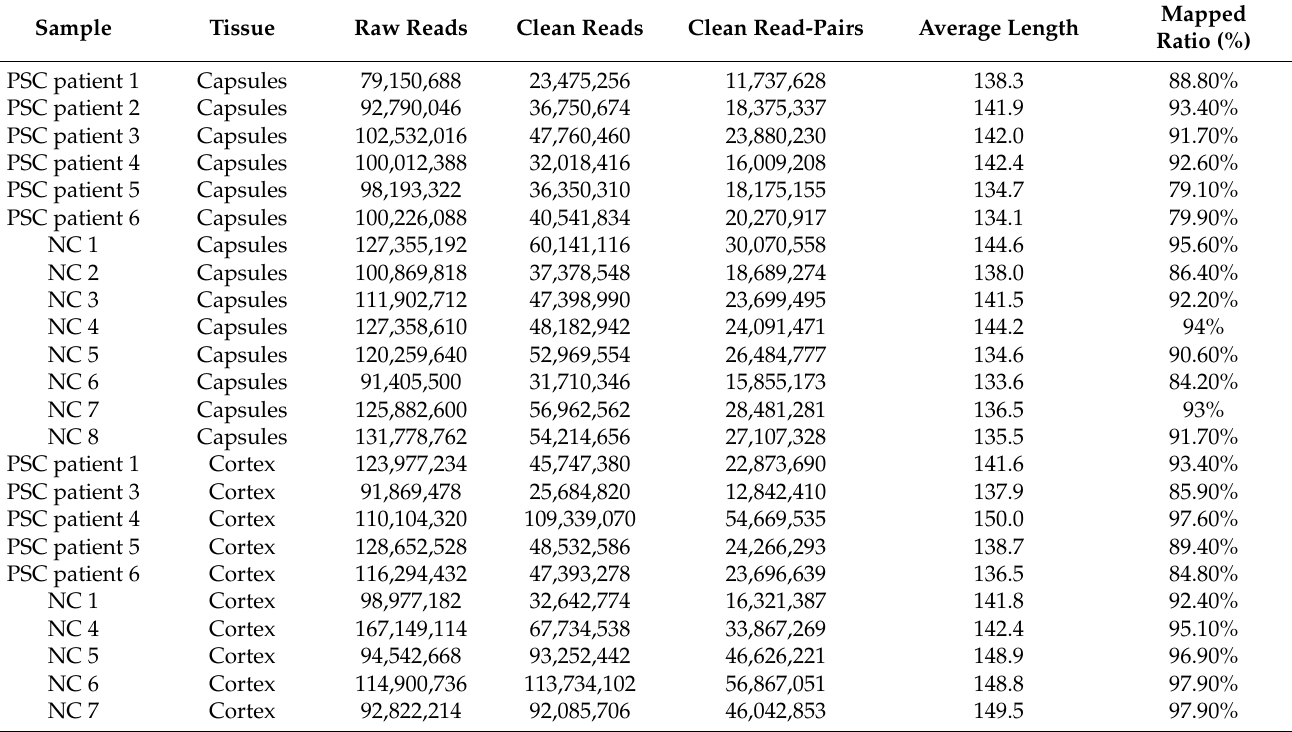
Table 2. RNA-seq samples, read metrics and mapped